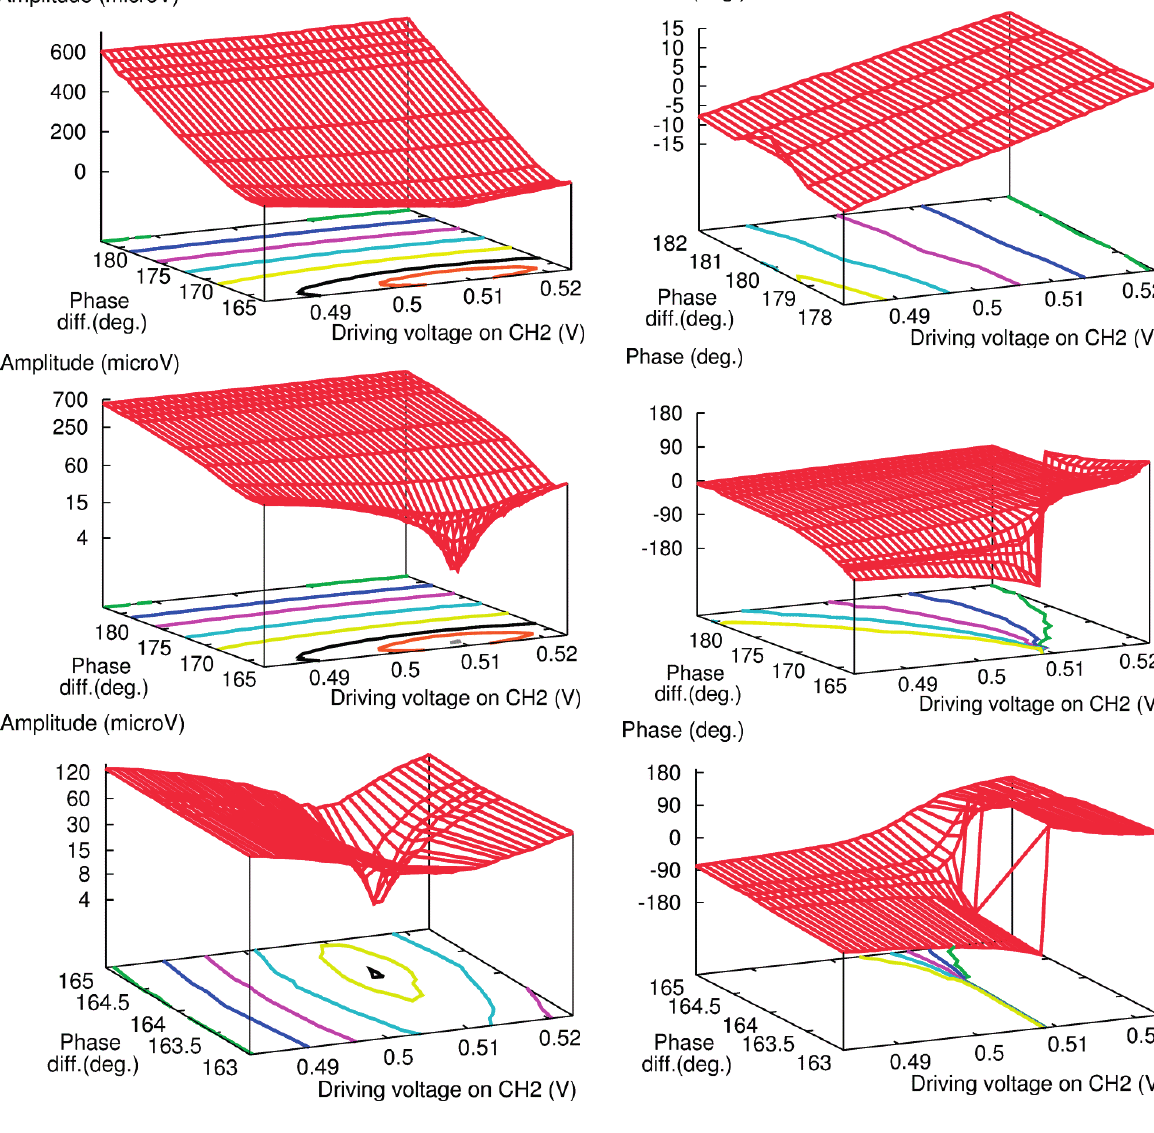
Figure 4. Systematic measurement of amplitude ( Left ) and phase ( Right ) of PA signal over a wide range of DV and phase difference at FG channel